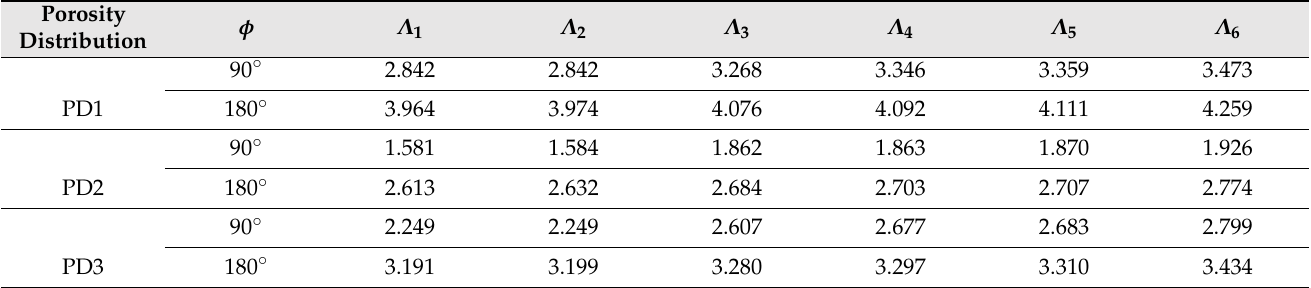
Table 4. Buckling loads (GPa) of FG-GPL, porous spherical caps for various polar angles and porosity distributions (GPLX, e 0 = 0.4, γ =